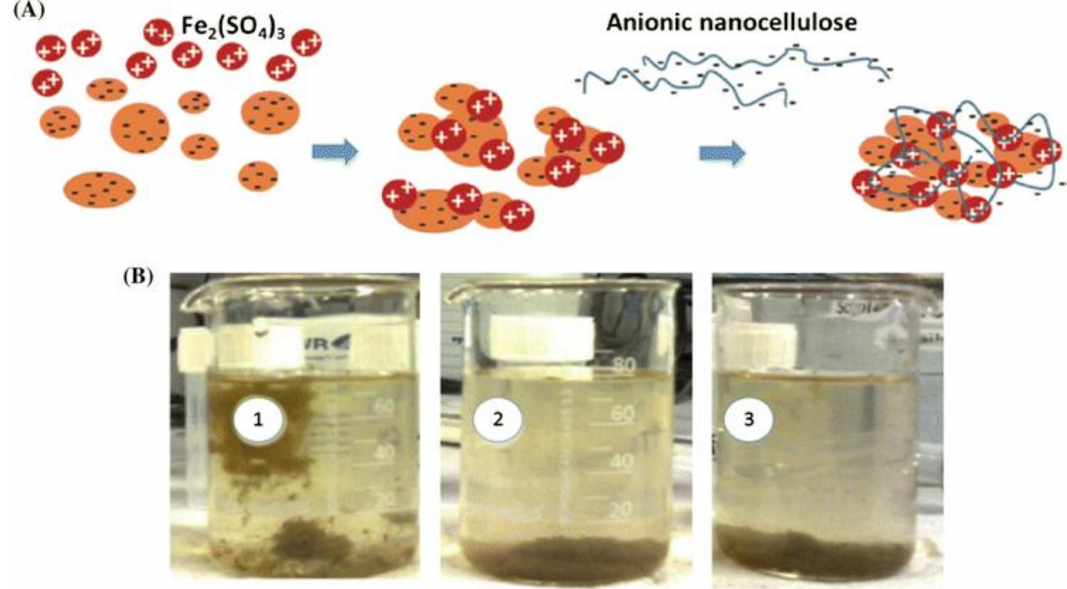
Figure 8. Flocculation mechanism of anionic nanocellulose to remove pollutants from water. ( A ) Binding and flocculation of cationic pollutants, and ( B ) visual observation of flocculation efficiency [10], ©Springer,